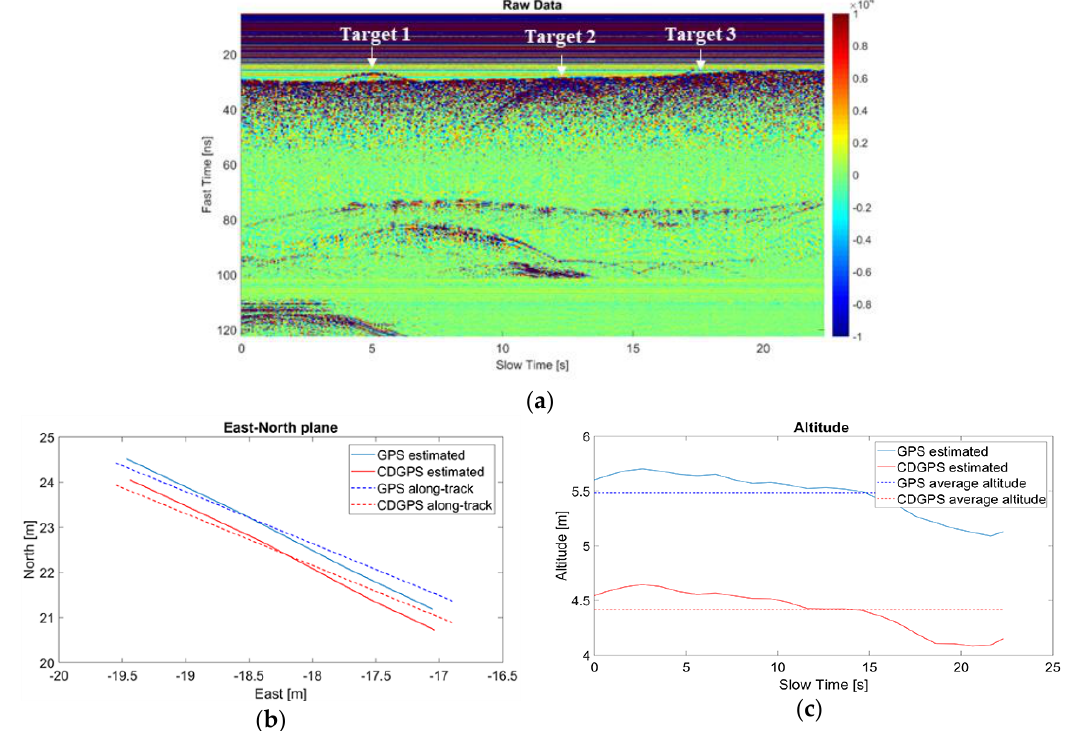
Figure 7. Test 1-Track 1: ( a ) raw data; ( b ) east–north UAV positions estimated by GPS (solid blue line) and CDGPS (solid red line), along-track direction defined by GPS (dashed blue line) and CDGPS (dashed red line); ( c ) UAV Altitude estimated by GPS (solid blue line) and CDGPS (solid red line), average altitude defined by GPS (dashed blue line) and CDGPS (dashed red line).